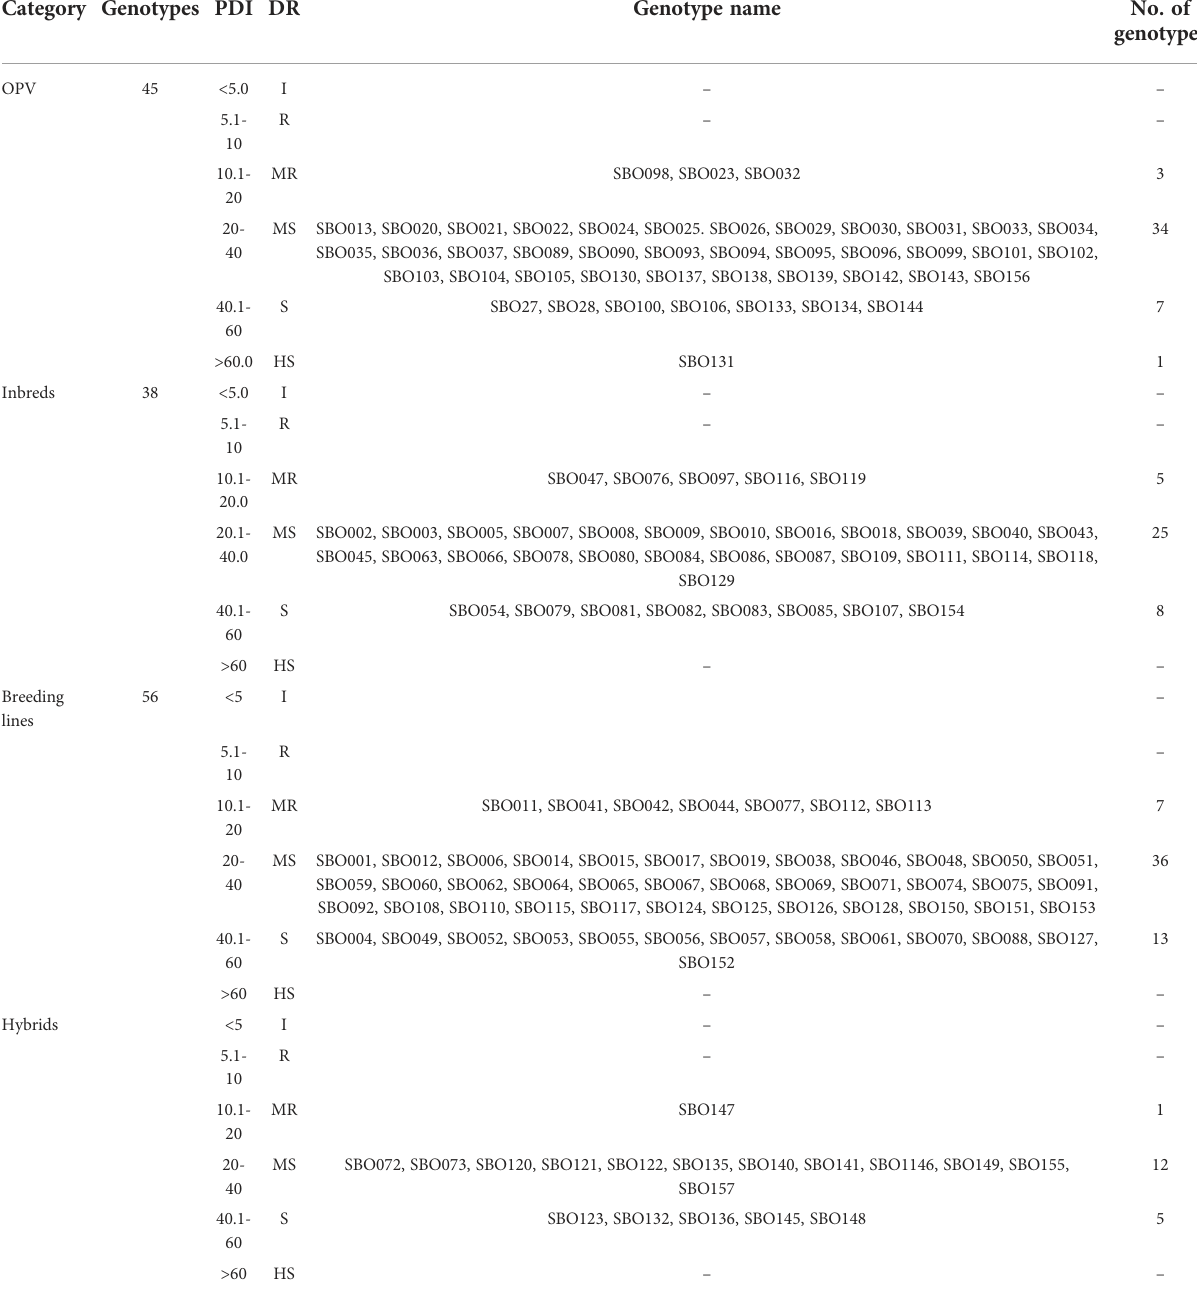
TABLE 3 Percent disease incidence (PDI) categories of 157 onion genotypes against Stemphylium vesicarium . Category Genotypes PDI